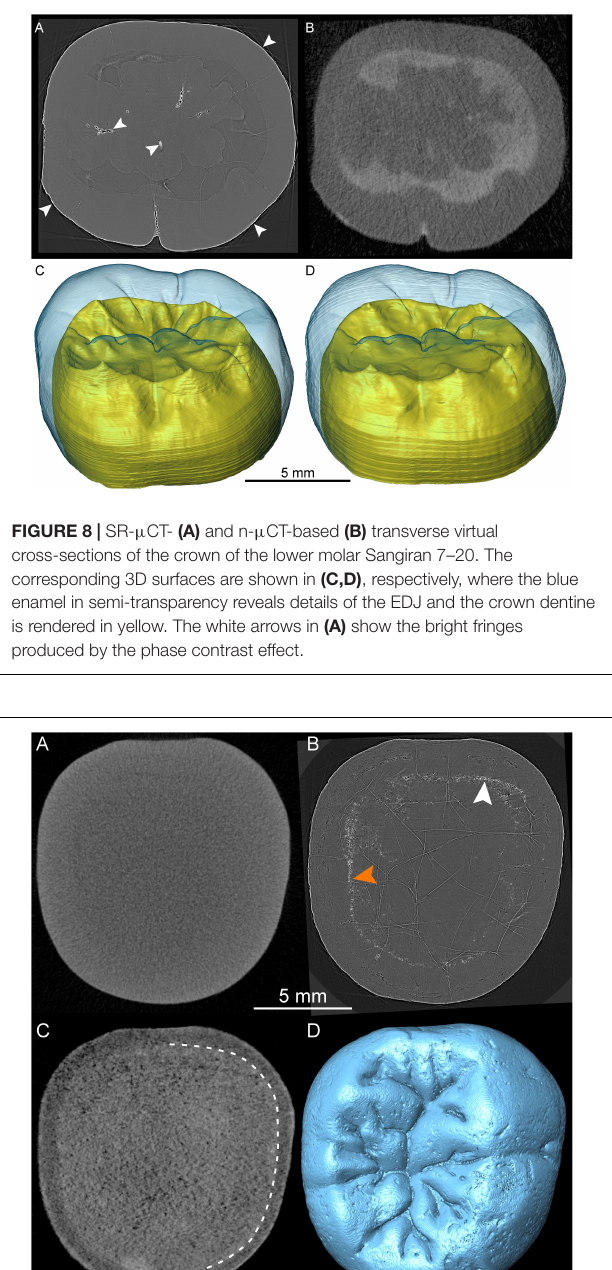
which depend on the atomic number of its elements.